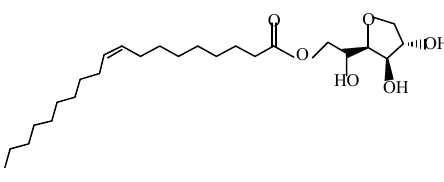
Figure 1. Structural formula of Span80.